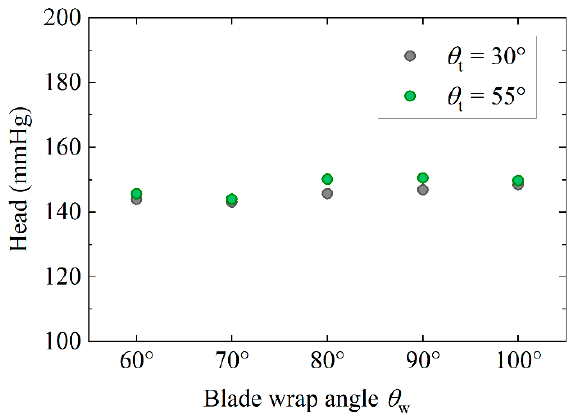
Figure 6. Hydraulic performances of 10 test pumps at the original design point by CFD simulation ( Q 0 = 5.0 L/min, n = 2500 r/min). Table 3. Numerical simulation results of the 10 pumps at the original design point.